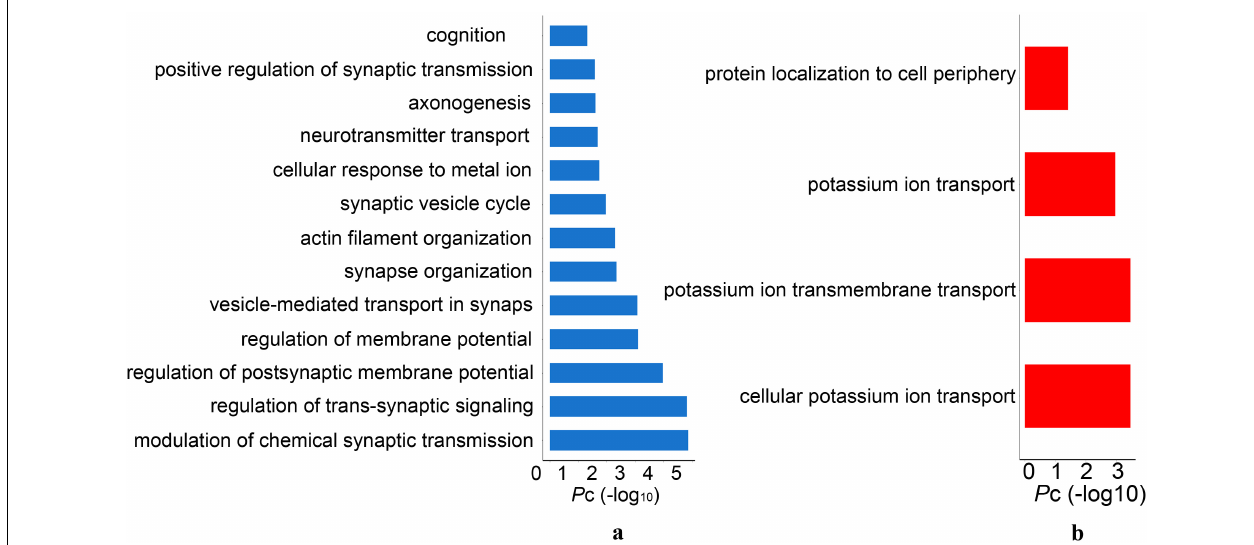
FIGURE 6 | The significant gene ontology terms of biological process for PLS1 gene sets. (A) The PLS1- genes were significantly enriched in synaptic signaling, neurotransmitter release, axonogenesis and cognition. (B) The PLS1 + genes were significantly enriched in potassium ion transport and protein localization. Pc , the Bonferroni corrected P